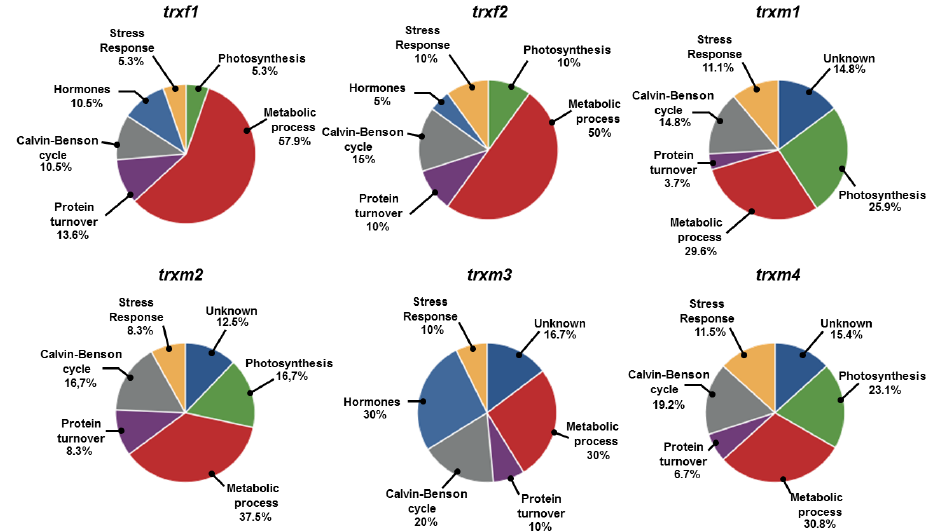
Figure 4. Degree of significance of the biological processes affected in the trx mutants in relation to the number peptides predicted to be involved in a process.